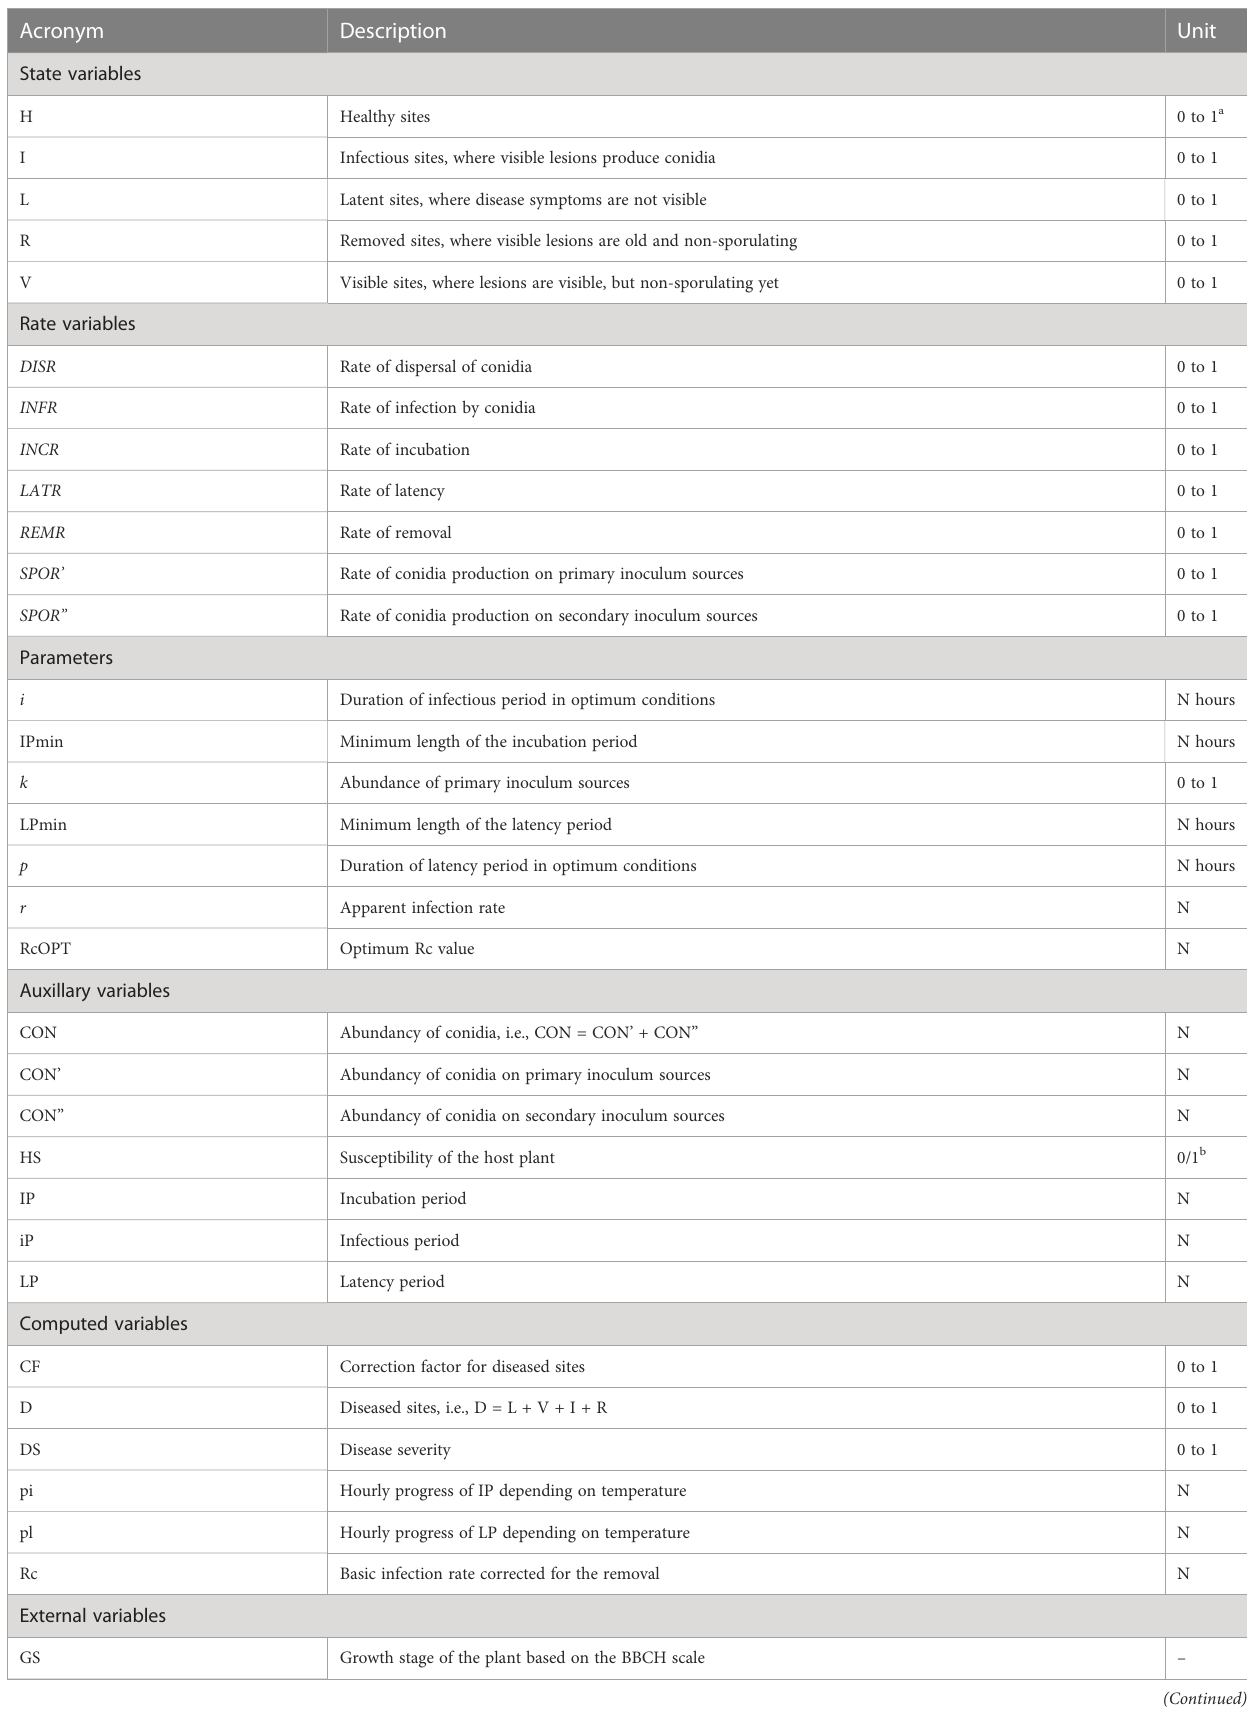
TABLE 1 List of variables, rates, and parameters used in the model, and their